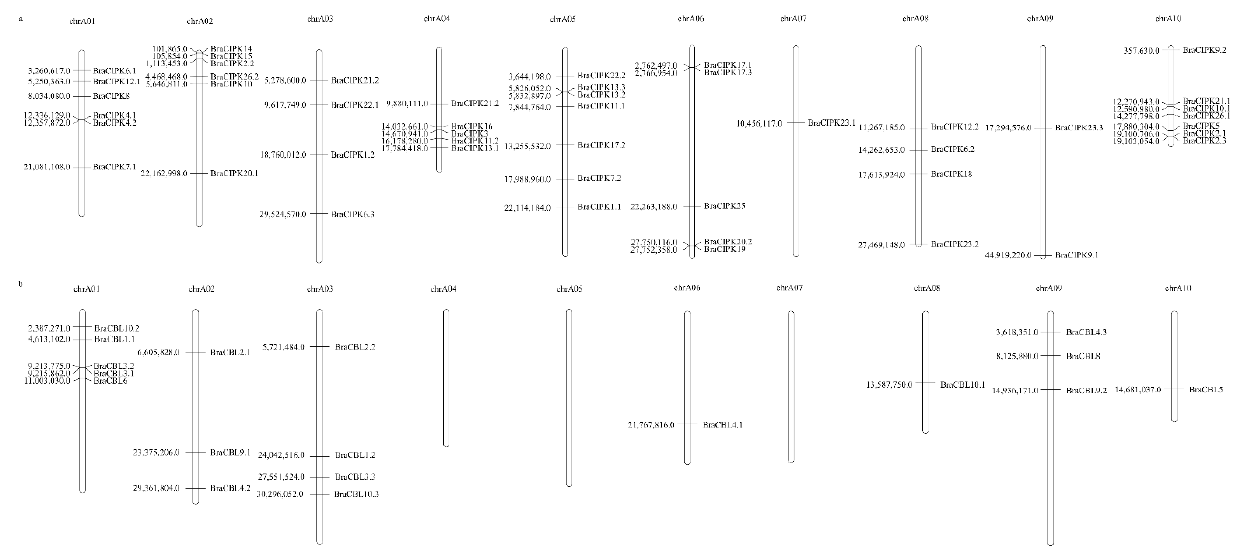
Figure 5. Chinese Cabbage CBLs and CIPKs Chromosome distributions. ( a ) BraCIPKs variably distributed among all on the turnip chromosomes. ( b ) The distribution of BraCBL on 10 chromosomes (Chromosome 4, 5, 7 containing no BrrCBLs).